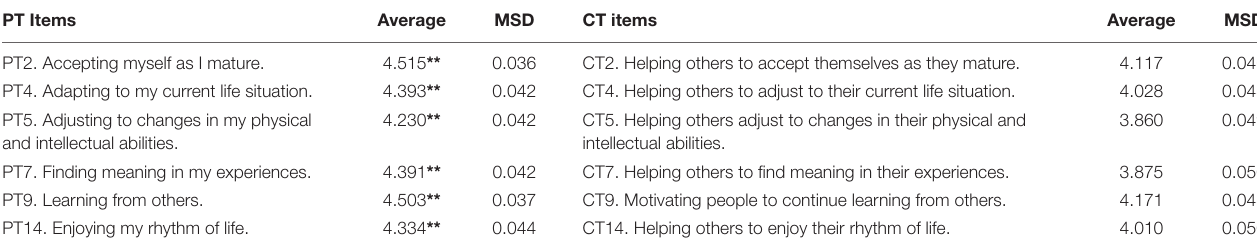
TABLE 2 | Answers to: How do I see myself at this moment in my life ( n = 392)? PT Items Average MSD CT items Average MSD PT2. Accepting myself as I